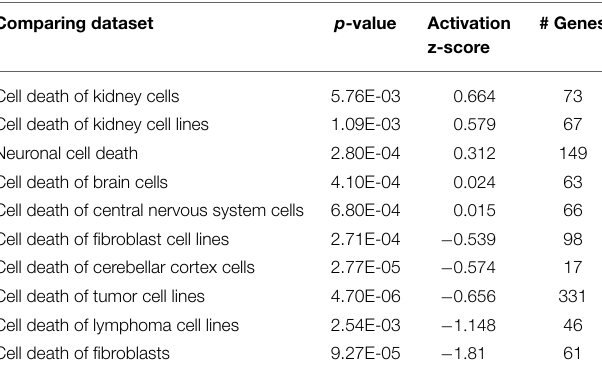
TABLE 1 | Comparison of the hair cell dataset with known expression changes during cell death in other tissues and cell types. Comparing dataset